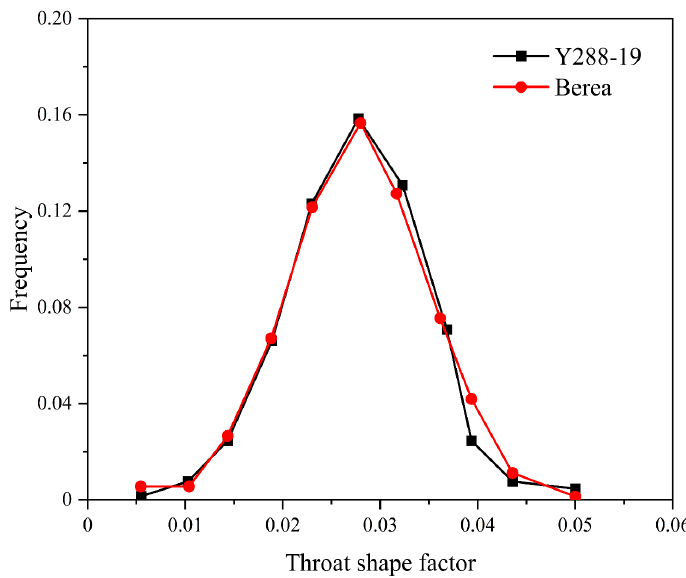
Figure 13. Throat shape factor of two types of cores.